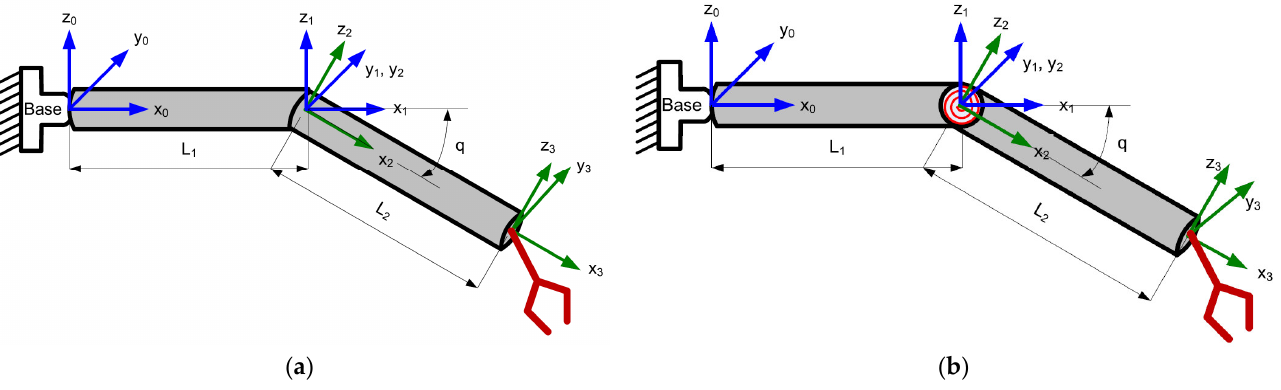
Figure 6. Two types of connections in a two-link serial system [63]: ( a ) a rigid connection and ( b ) an elastic connection.